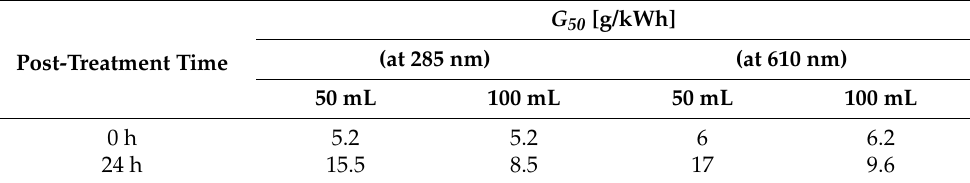
Table 1. Energy yield G 50 for 50 mL and 100 mL of IC solution calculated at 285 nm and 610 nm at 0 h and 24 h post-treatment.